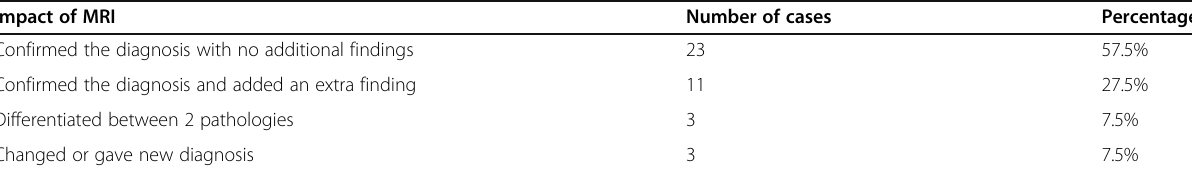
Table 2 Impact of MRI on diagnosis Impact of MRI